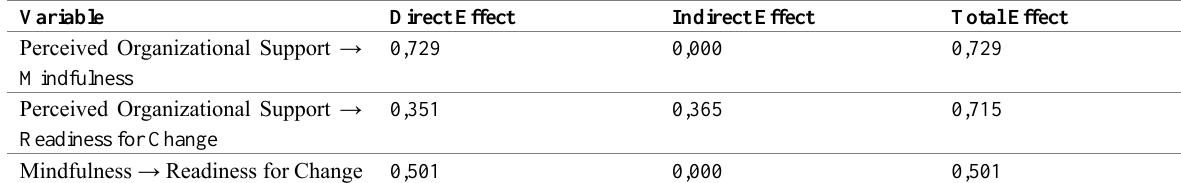
Table 6: Results of Direct, Indirect, and Total Effect